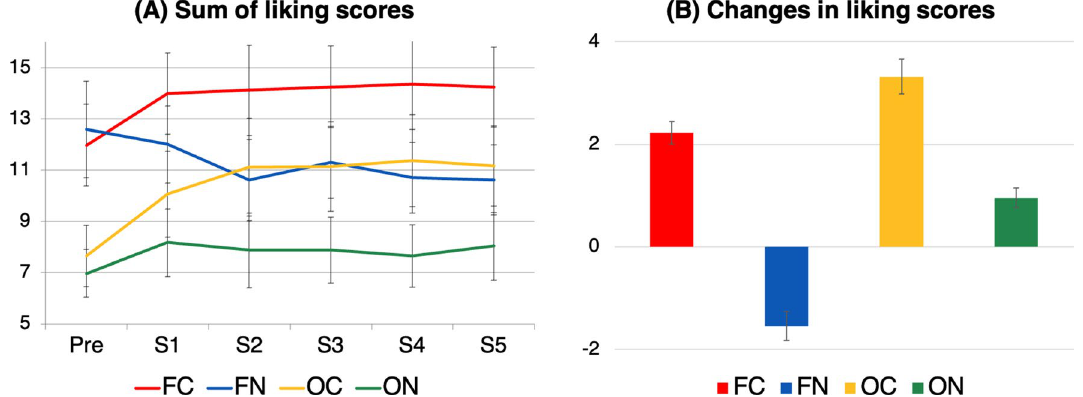
Figure 2. Participants’ mean liking scores before and at the end of the experiment. ( A ) Liking scores for each condition and session [from session 1 (S1) to session 5 (S5)], as well as before the experiment (Pre). The liking score was calculated as the sum of three questionnaire item scores. The participants’ mean liking scores are presented graphically; error bars represent 95% confidence intervals (CIs). ( B ) Changes in liking scores for each condition. Changes in liking scores were calculated as the difference between the pre-experiment and mean liking scores for S1–S5 (i.e., [(S1 + S2 + S3 + S4 + S5)/5] − [Pre]). Error bars represent 95%